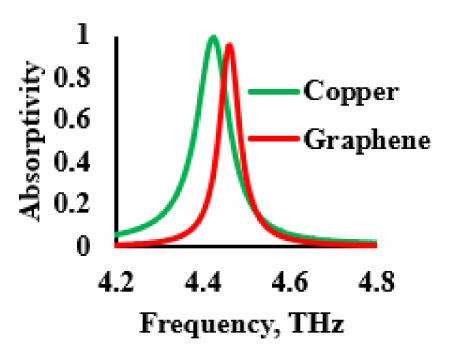
Figure 9. Absorption characteristics of different conductors used in the development of